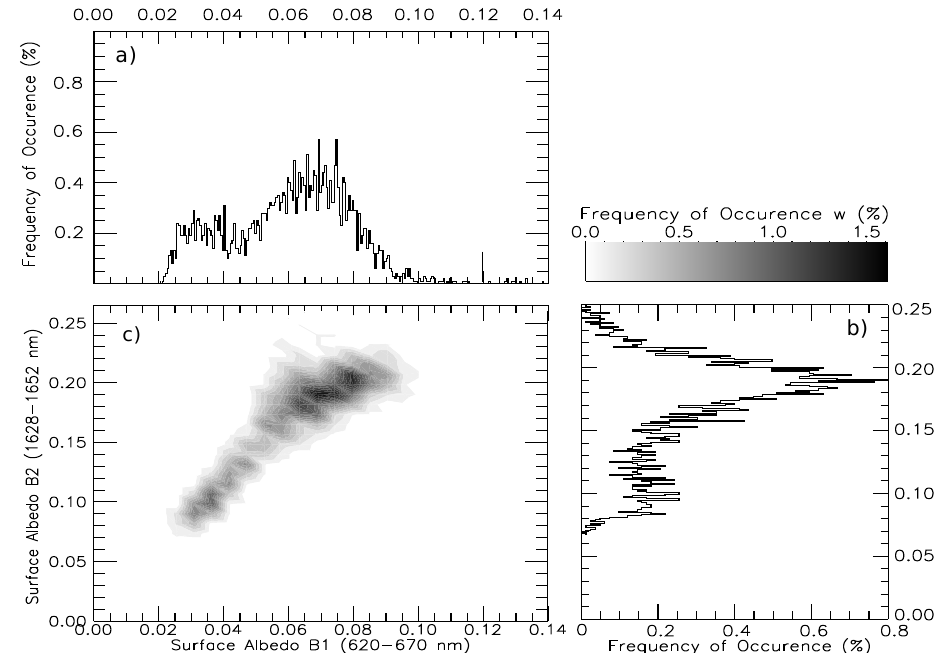
Fig. 5. Two-dimensional (2-D) frequency distribution of the combined B1 and B6 surface albedo from MODIS for the rectangle-shaped area including the flight track covering an area of approximately 3600km 2 (approach 1). Each value stands for a surface albedo pair with a bin size of 0.001. In panels (a) and (b) the separate B1 and B6 distributions are displayed.